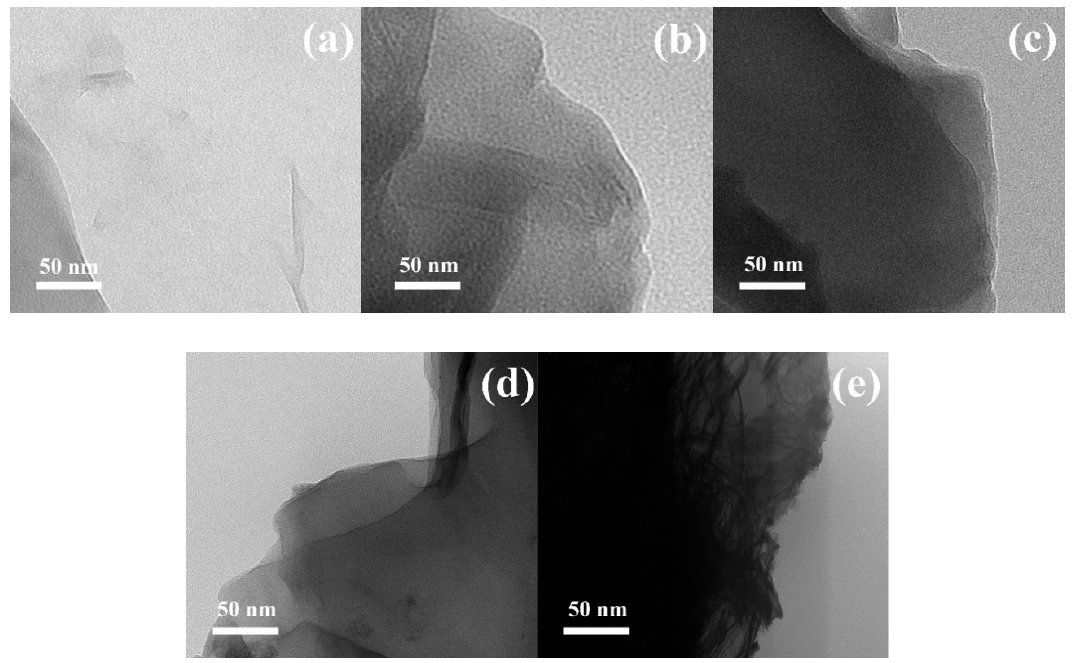
Figure 1. TEM images of: ( a ) the neat GO; and modifications with various polymers: ( b ) GO-poly(methyl methacrylate) (PMMA), ( c ) GO-poly( n -butyl methacrylate) (PBMA), ( d ) GO-poly(glycidyl methacrylate) (PGMA), ( e ) GO-poly(trimethylsilyloxyethyl methacrylate) (PHEMATMS).